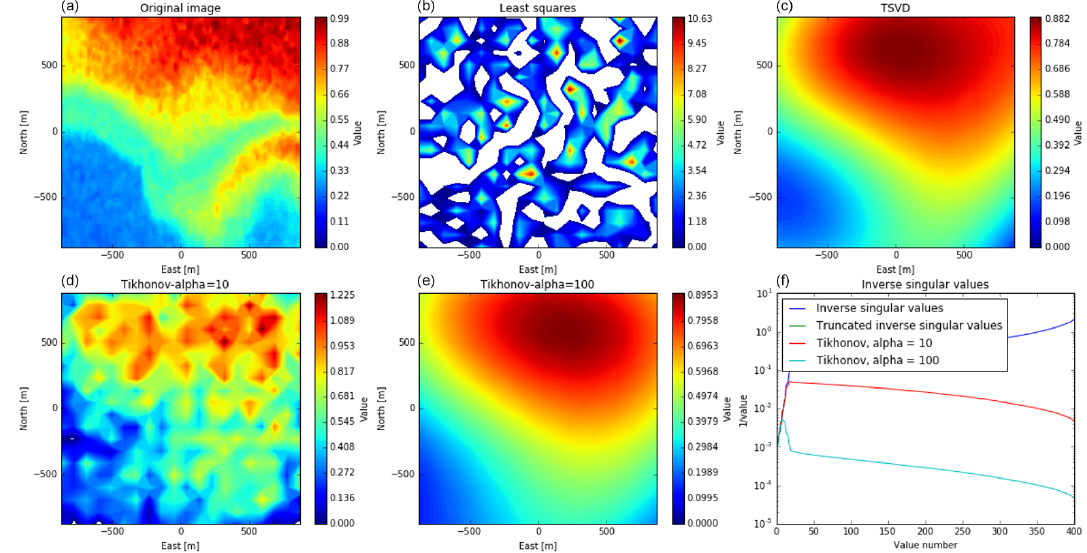
Figure 9. Comparison of reconstructions, using SVD for the SIMO case only, using the core antennas. Panel (a) shows the true image. Panel (f) shows the inverse of the singular values of the theory matrix. The other figures show reconstructions with different weightings of the singular values. Panel (b) has no weighting and corresponds to the ordinary least squares method. In panel (c) , the singular values below 2% of the largest singular value are ignored/truncated away. In panels (d) and (e) , the inverse of the low singular values are damped, like in Eq. (33), with regularizing parameters α of 10 and 100, respectively. The reconstructions consider an image resolution of 20 × 20 pixels, at 100km altitude, where one pixel corresponds to 100 × 100m. White spaces in the colour plots correspond to negative